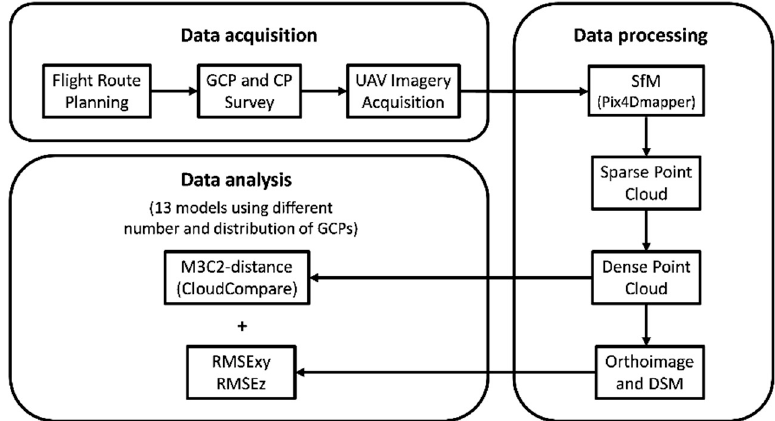
Figure 1. Workflow of image acquisition and processing to assess the influence of number and distribution of ground control points (GCPs) on the accuracy of linear photogrammetric projects.